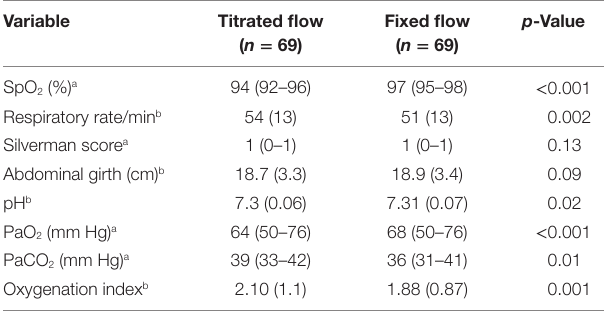
TaBle 3 | comparison of clinical parameters.